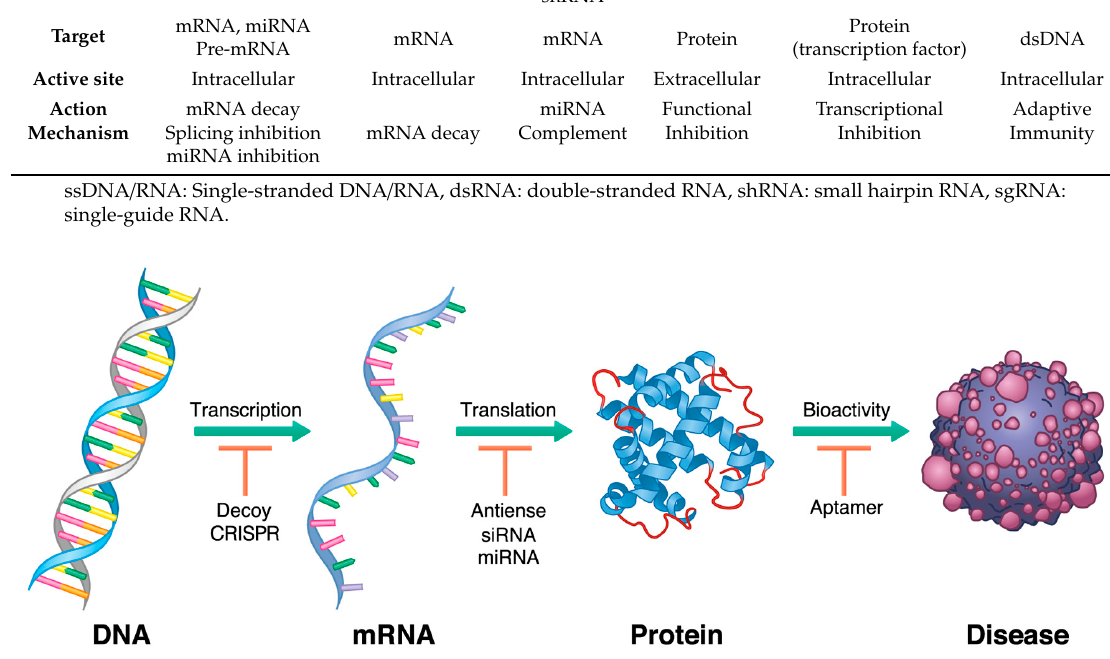
Figure 1. Therapeutic oligonucleotides act on di ff erent stages of pathological gene expression. Standard schematic of oligonucleotide activities in pathogenesis disease progression. Decoys bind to transcription factors of targeted DNA at the earliest phase. Subsequently, antisense RNA, small interfering RNA (siRNA), and microRNA (miRNA) act to target mRNAs. Then, aptamers directly inhibit proteins in the process of pathogenesis.